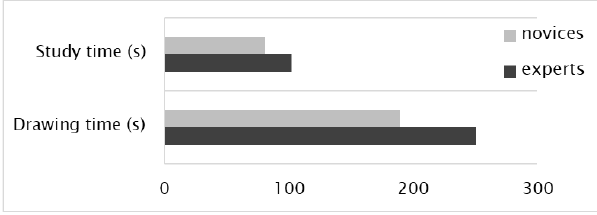
Figure 3. Trial durations of experts and novices.